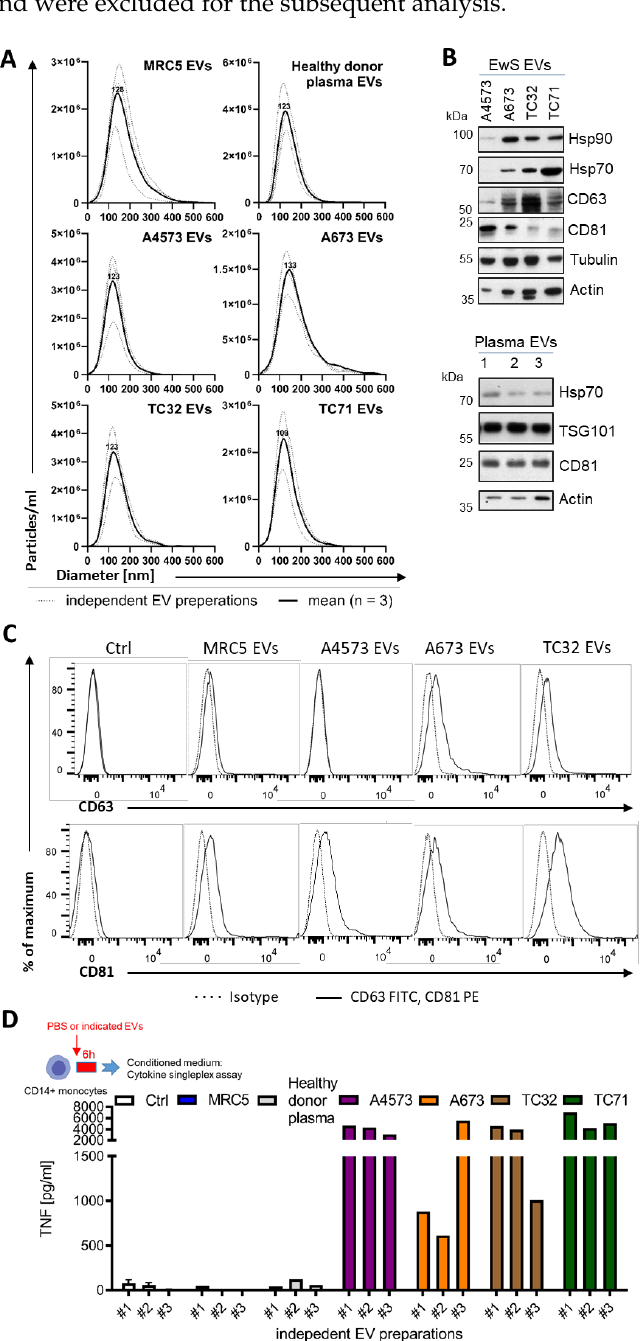
Figure 1. Purification and characterization of EV preparations from EwS and fibroblast cell lines and healthy donor plasma. ( A ) Size distribution of EVs isolated by ultrafiltration and differential centrifugation from healthy donor plasma, MRC5 fibroblasts, and A4573, A673, TC32, and TC71 EwS cell lines. Nanoparticle tracking analysis of three independent EV preparations (dotted line) and respective mean (solid line) is shown. ( B ) Immunoblotting-detection of chaperon proteins Hsp70 and Hsp90, EV markers CD63, CD81 and TSG101, tubulin and actin in the purified EV prep- arations from EwS cell lines and healthy donor plasma ( n = 3 independent donors). ( C ) Expression of the CD63 and CD81 EV markers (solid line) compared to IT antibodies (dotted line) on MRC5